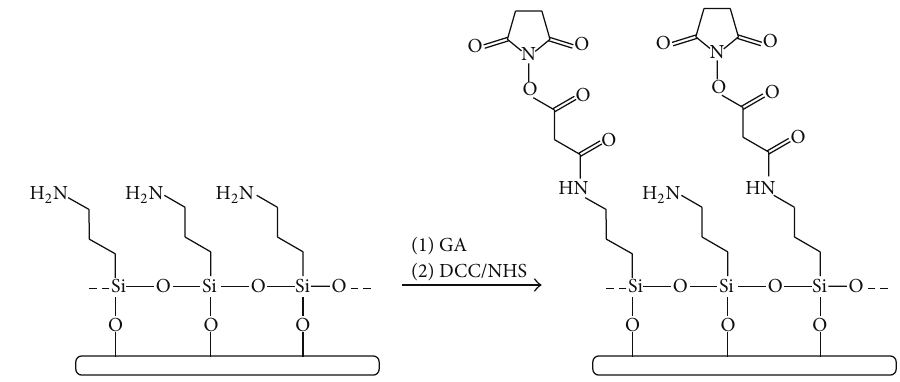
Scheme 3: Surface modification with activated carboxylic